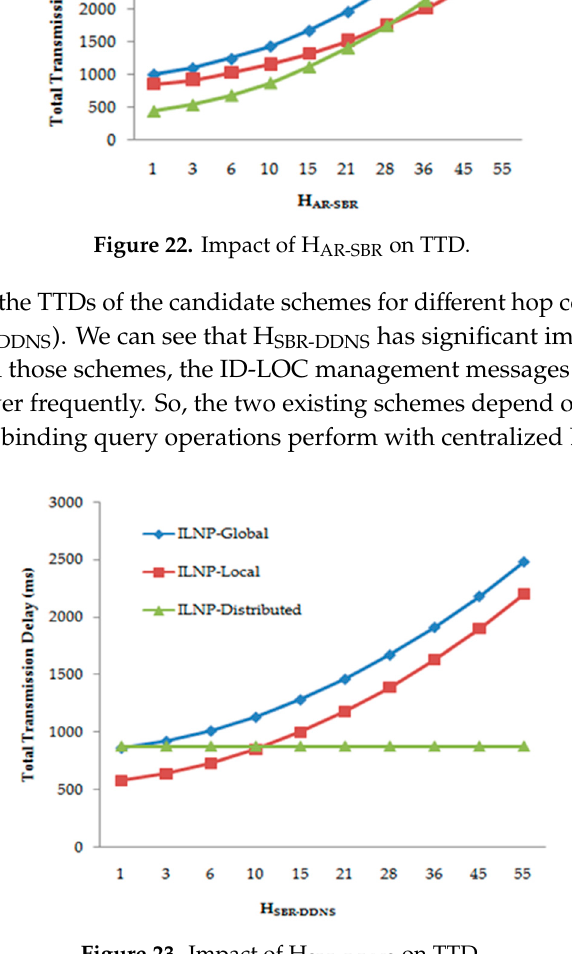
Figure 23. Impact of H SBR-DDNS on TTD.